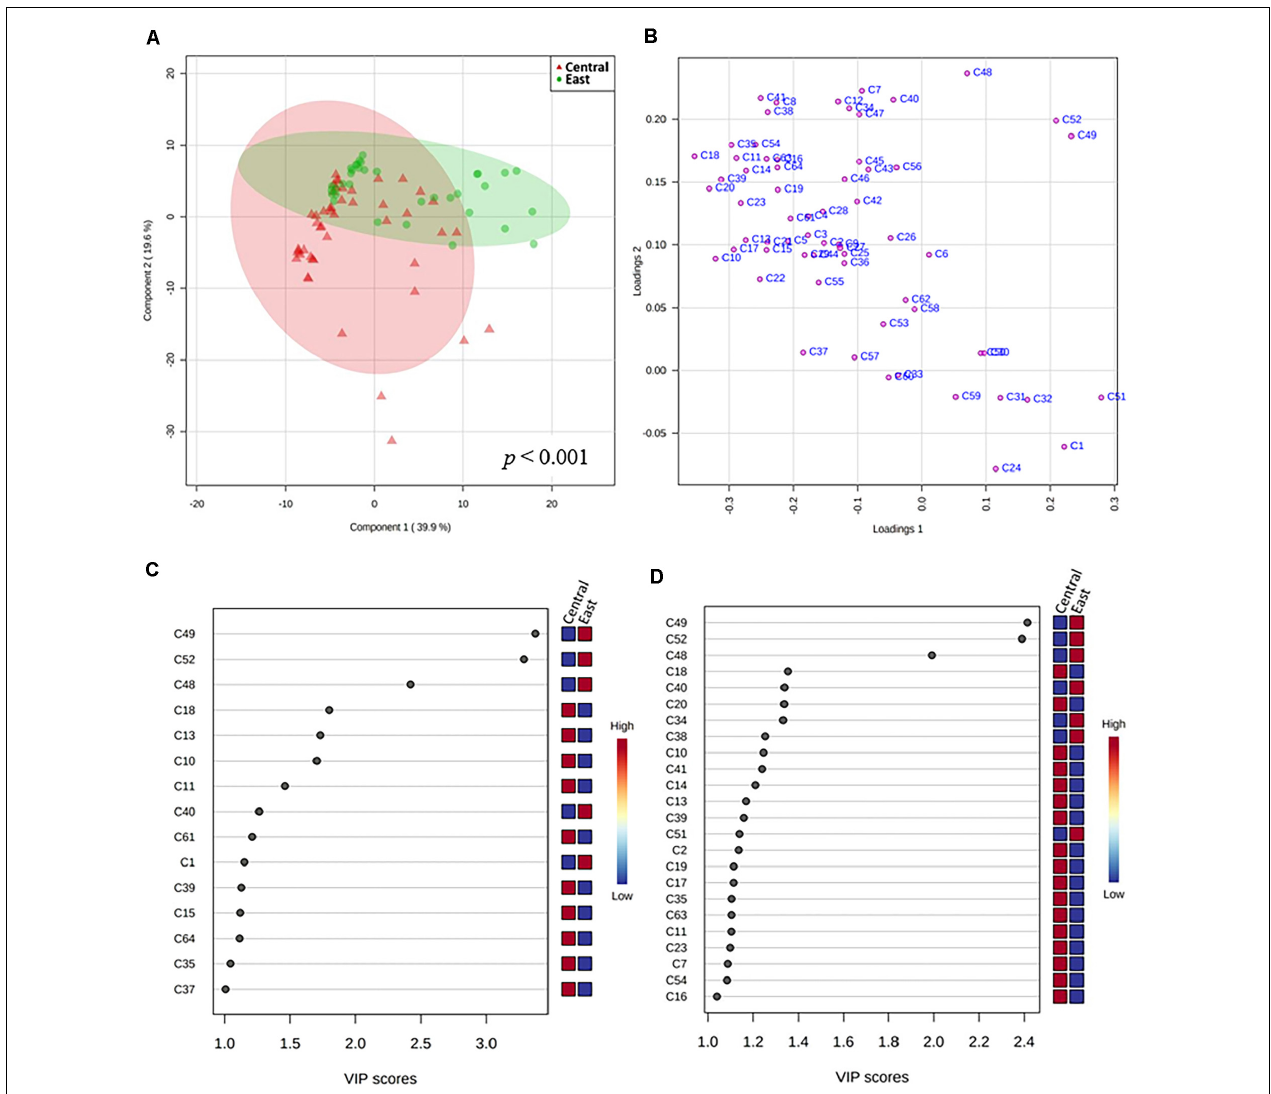
FIGURE 6 | PLS-DA of volatile metabolites from fermentation samples collected from five Central and four East wineries. (A) Score plot showing individual samples from both regions with 95% confidence ellipses for the regions with permutation-obtained p -value of p < 0.001. (B) Loadings plot showing volatile metabolites; Important features in (C) PC1 and (D) PC2 based on variable importance in projection (VIP) values. The colored boxes on the right of the VIP scores indicate the relative concentrations of the corresponding metabolite in each region under study (VIP > 1). Note: Volatile metabolite codes are provided in